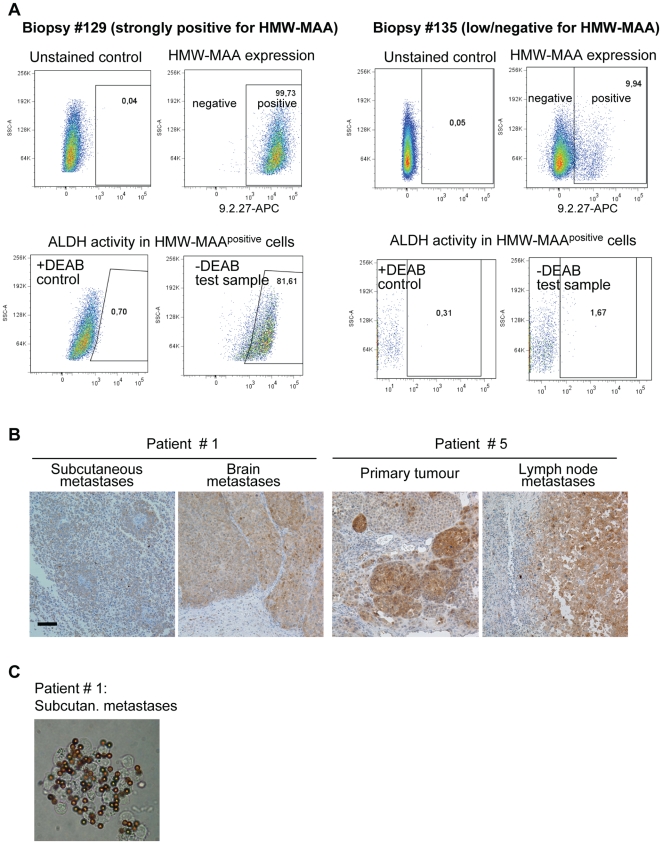
Identification of ALDH+ cells in patient biopsies.(A) Flow cytometric analysis of cells from fresh LN biopsies stained by Aldefluor and co-stained with APC-labelled 9.2.27Ab binding to HMW-MAA. Dot-plots show HMW-MAA staining (upper panel) and ALDH activity (lower panel) in two representative biopsies #129 and #135, differing in the HMW-MAA levels and the ALDH activity. “Unstained controls” were used to set the gates defining HMW-MAA+ cells; “+DEAB controls” were used to set the gates defining ALDH+ subpopulations in “−DEAB test samples”. A supplementary information regarding the analysis of these biopsies is presented in Figure S3. (B) ALDH immunostaining in the biopsies from patients #1 and #5: subcutaneous and brain metastases (from #1); primary tumour and LN metastases (from #5). Bar, 100 µm. (C) A representative picture, here for the biopsy from patient #1 (used for establishment of Melmet 1), illustrating 9.2.27Ab-magnetic beads binding to melanoma cells, which confirms HMW-MAA positivity in the biopsy.